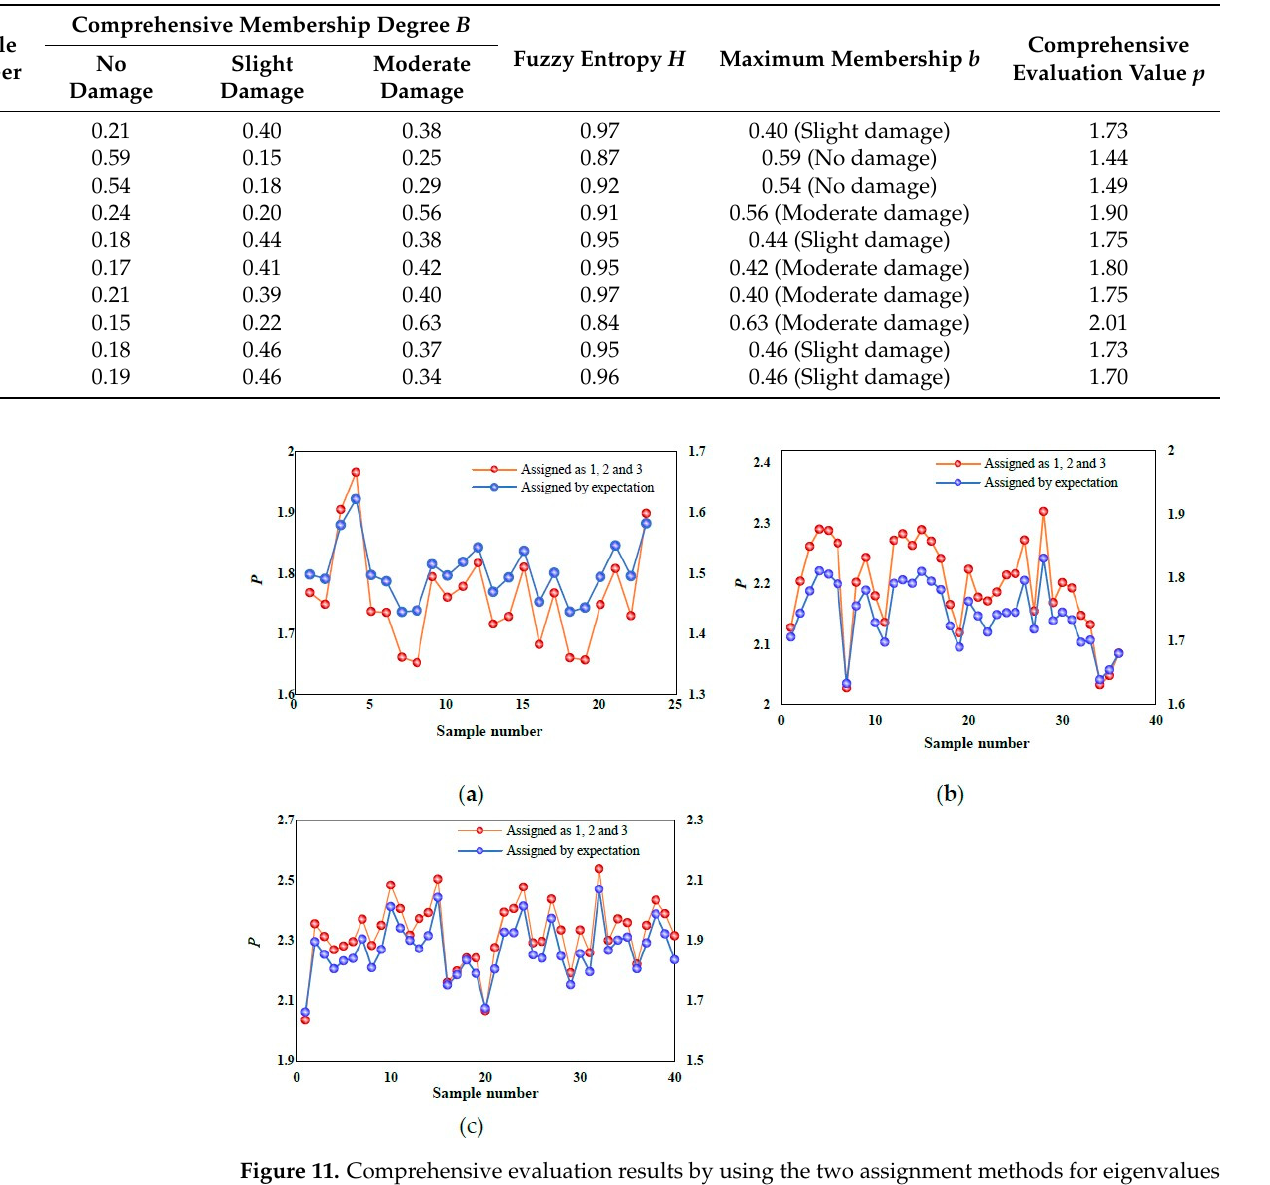
Table 8. Evaluation results of partial data samples in the Ashele Copper Mine.